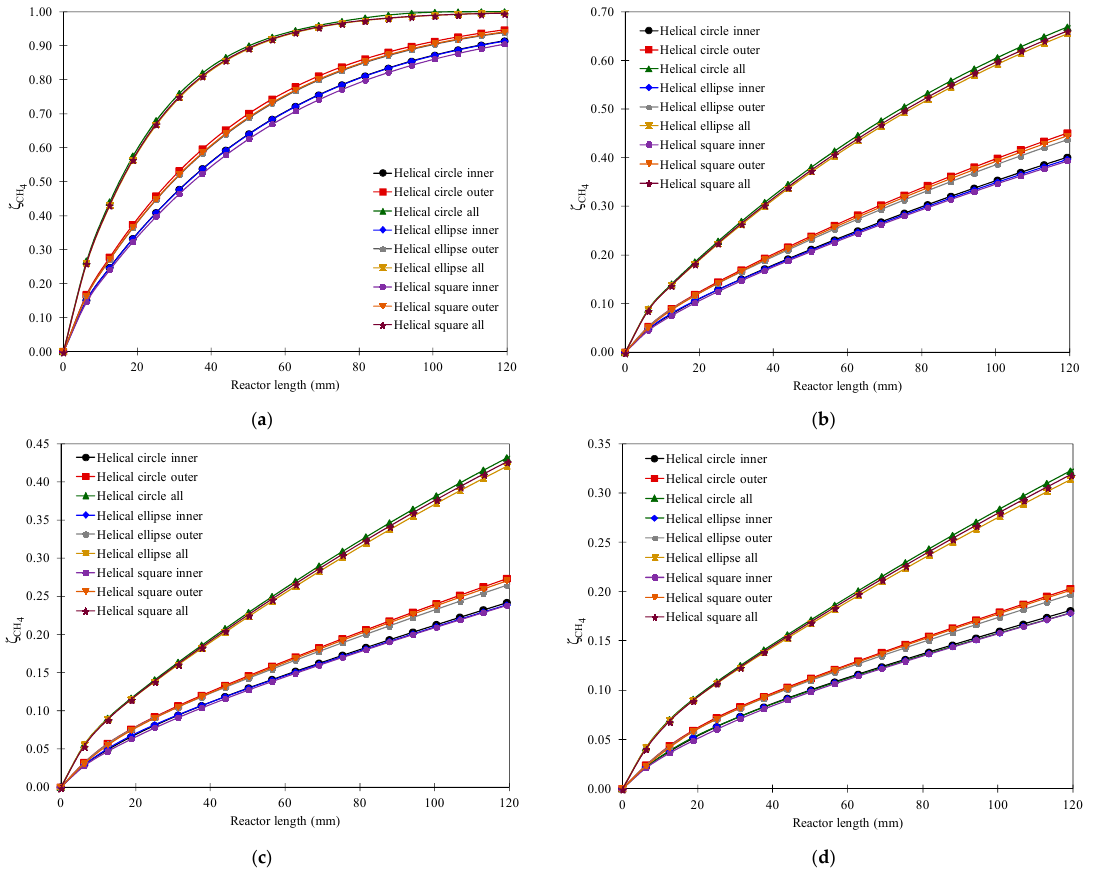
Figure 10. Methane conversion along the helical reactors at Reynolds numbers of ( a ) 100, ( b ) 500, ( c ) 1000, and ( d ) 1500.